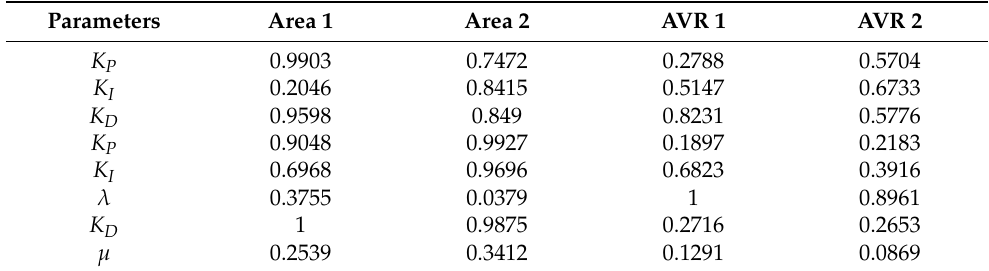
Table 12. Cascaded PID-FOPID controllers’ gain for SMES-SMES-GCSC coordination.